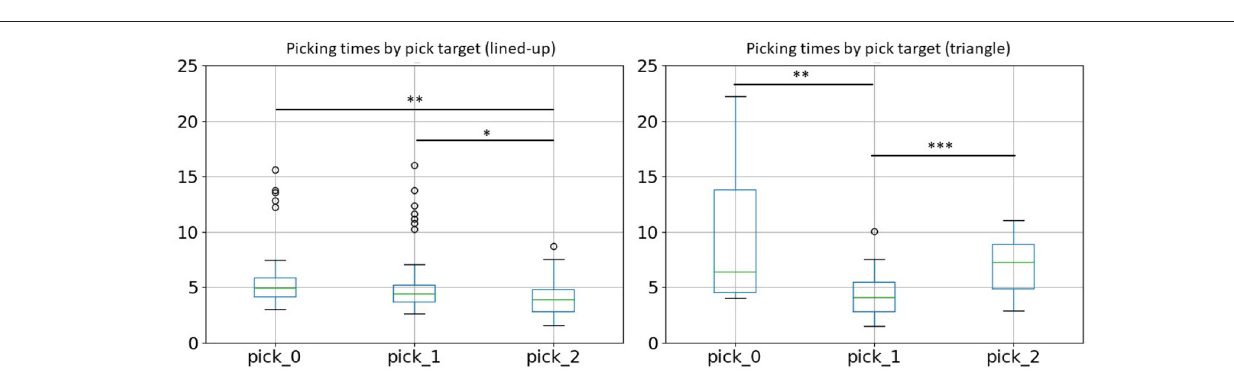
Figure 9 sketches the online intention recognition